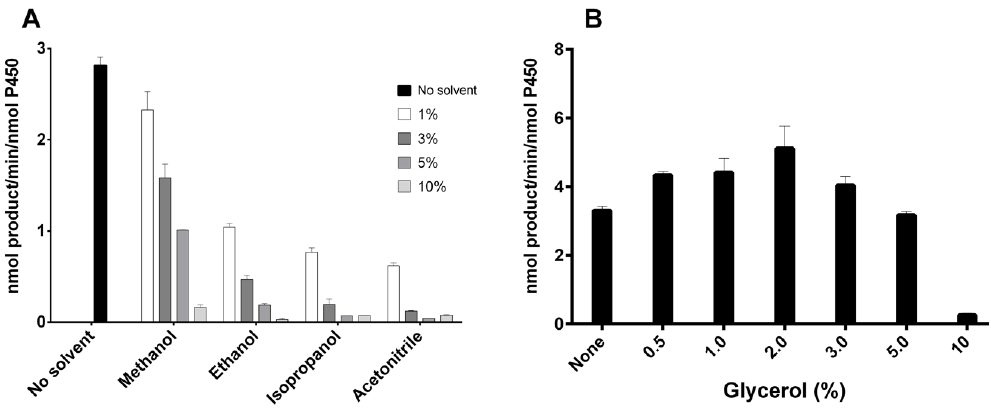
Figure 7. The cosolvent’s effect on atorvastatin hydroxylation supported by hydrogen peroxide. The reaction mixtures included atorvastatin substrate at 200 μM, 0.20 μM whole M371, and indicated cosolvent in 100 mM of a potassium phosphate buffer (pH 7.4). ( A ) Cosolvent (methanol, ethanol, isopropanol, and acetonitrile) with 1%, 3%, 5%, and 10% ( v / v ). ( B ) Cosolvent: glycerol with 0.5%, 1%, 2%, 3%, 5%, and 10% ( v / v ).